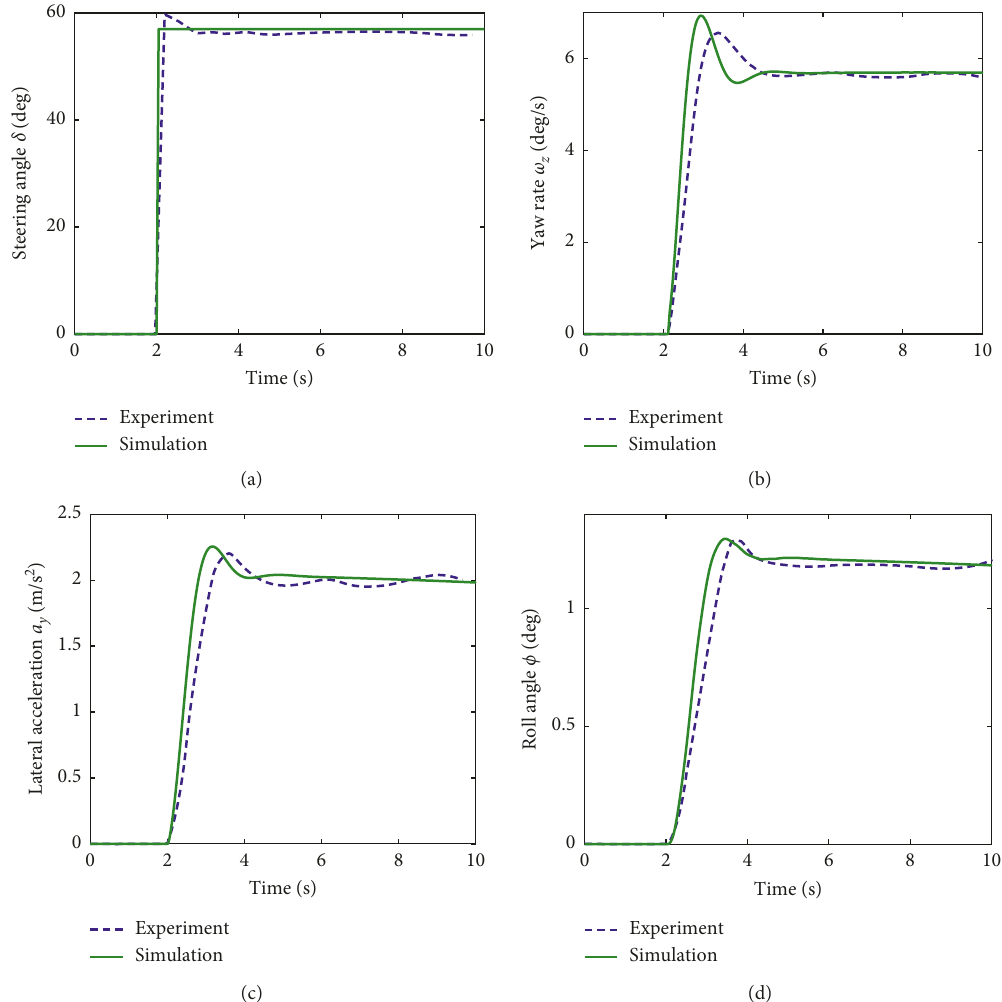
Figure 12: Step input condition results: (a) steering wheel angle; (b) yaw rate; (c) lateral acceleration; (d) roll angle.